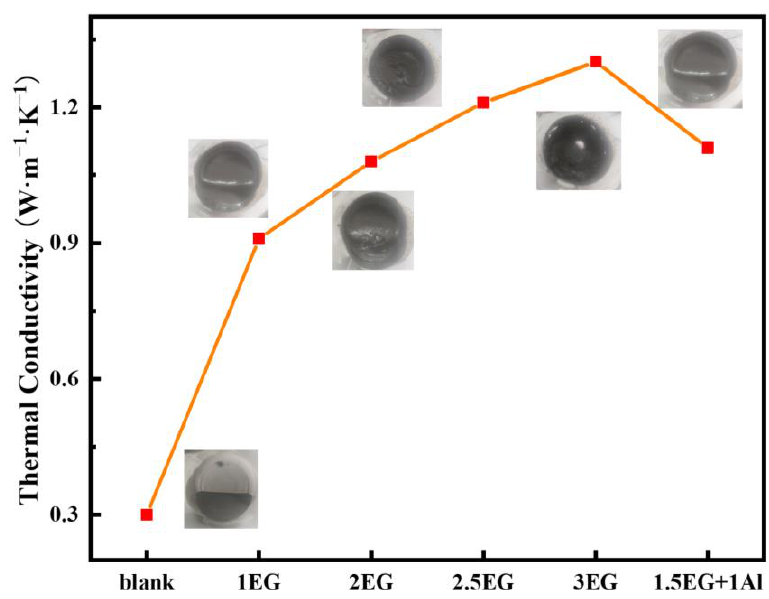
Figure 6. Thermal conductivity of different CSG.